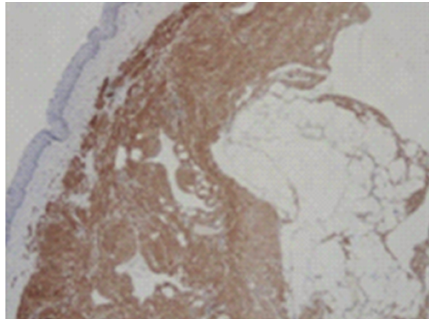
Figure 3: Smooth muscle component showing immunoreactivity to SMA (SMA; magnification ×